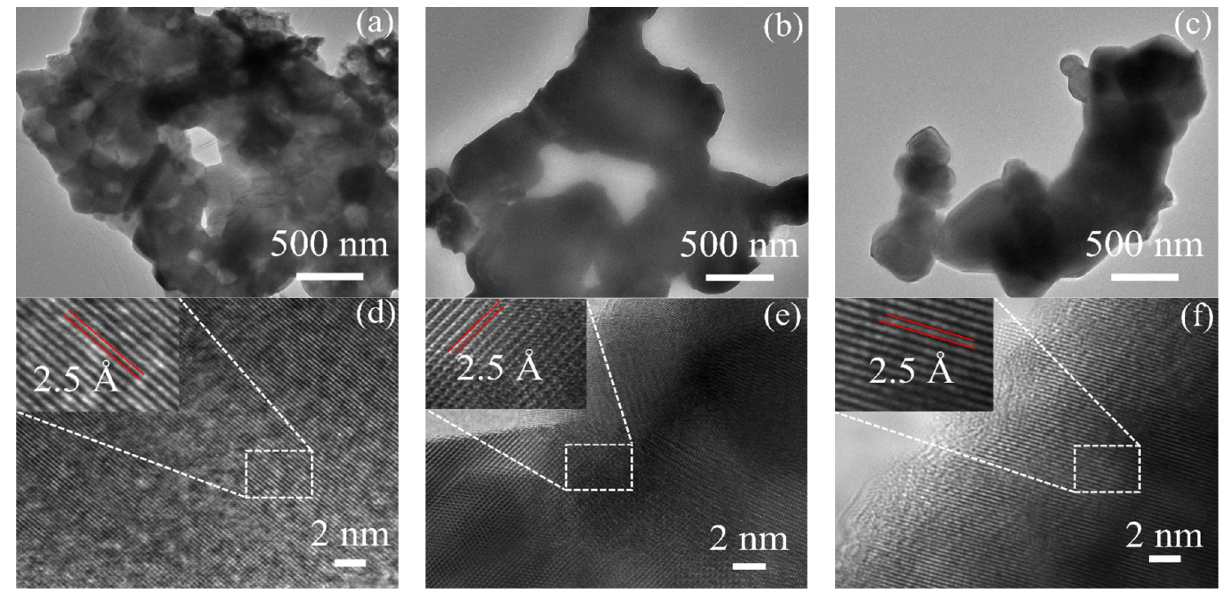
Figure 4. ( a – c ) TEM and ( d – f ) high-resolution TEM images of HEO − Zn, HEO − Cu, and HEO − Mn samples, respectively. Insets of ( d – f ) are magni fi ed images of the relevant areas marked in ( d – f ).